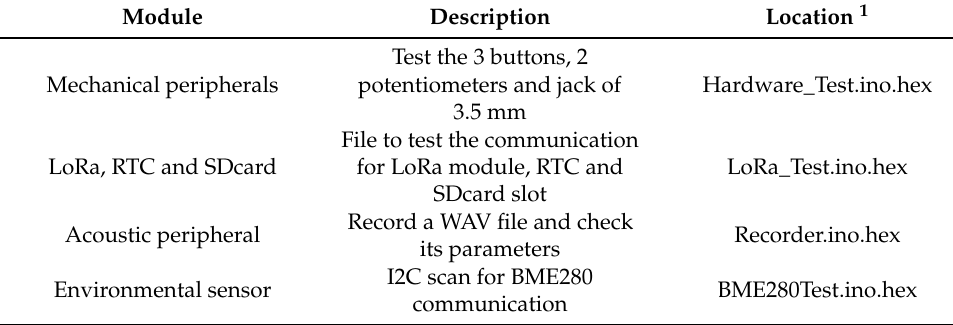
Table 5. Programed test files location.